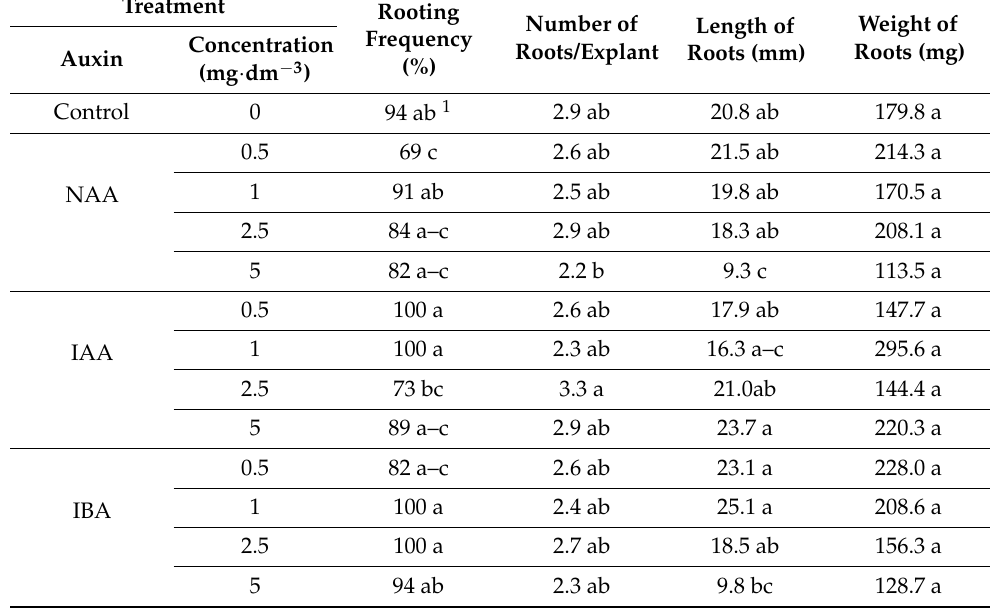
Weight of Roots (mg)Auxin Concentration